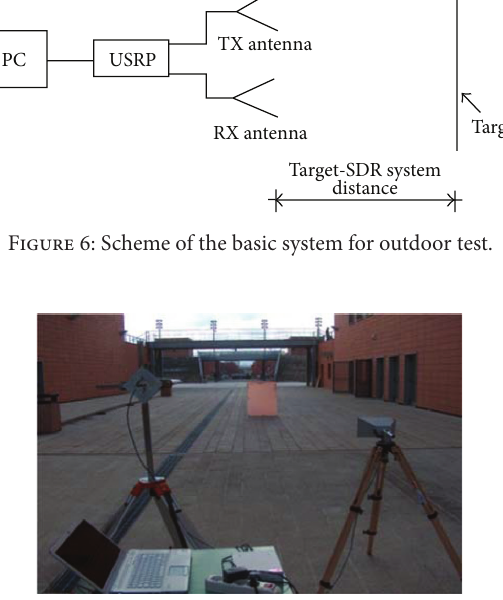
Table 1: Real and retrieved target positions with the NI-USRP